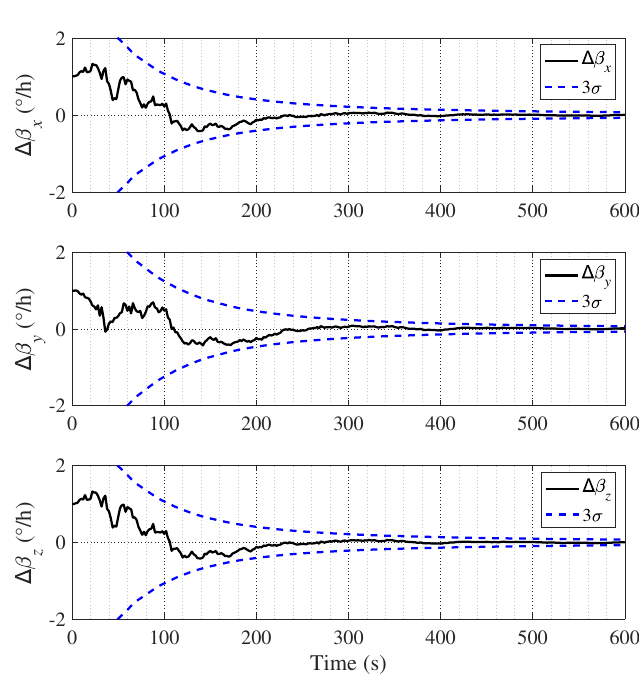
Figure 15. Gyro drift